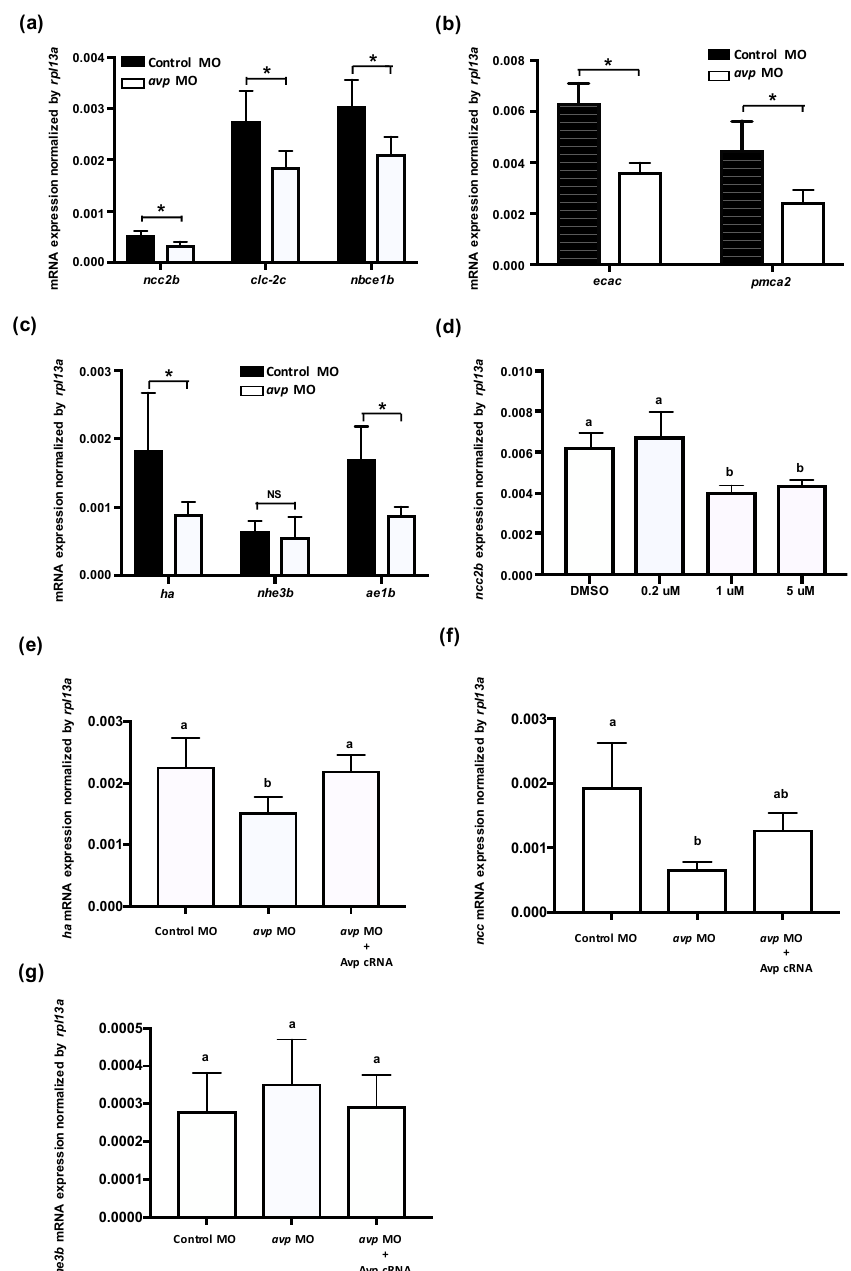
Figure 3. E ff ects of morpholino-mediated downregulation of Avp on the mRNA expression of ionocyte-related genes. Comparison of mRNA levels encoding ion transporters in 3-dpf-lavae injected with control morpholino (black bar) and avp morpholino (white bar); genes for NCC2b, CLC-2c, and NBCe1b were expressed in NCC cells ( a ); ECaC and PMCA2 were expressed in Na +/ K + -ATPase rich (NaR) cells ( b ); HA, NHE3b, and AE1b were expressed in NCC and H + -ATPase rich (HR) cells ( c ). The NCC2b expressions were significantly downregulated by antagonist SR49059 treatments (1 and 5 µ M) ( d ). Co-injection of avp MO and Avp cRNA rescued the mRNA expressions of ha ( e ) and ncc2b ( f ), while the nhe3b mRNA expression was not a ff ected by avp MO and Avp cRNA ( g ). Bracket labeled with NS indicates no significant di ff erence from control MO-injected samples. Values are mean ± s.e.m. ( n = 4–5). Brackets with asterisks indicate a significant di ff erence from control, according to Student’s t -test, p < 0.05. Di ff erent letters indicate a significant di ff erence between each treatment, according to one-way ANOVA, Tukey’s pair-wise comparison, p <